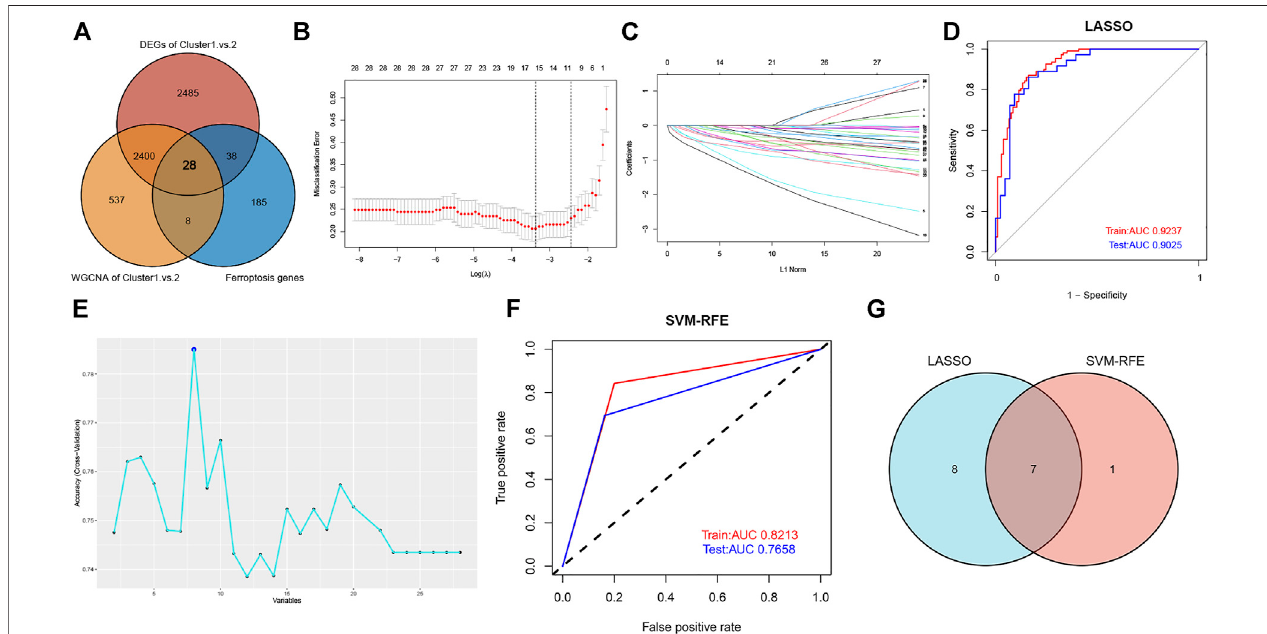
FIGURE 8 | Construction of ferroptosis signature using machine learning algorithms. (A) Venn plot showing the co-expressional ferroptosis genes by intersecting the DEGs with the ferroptosis genes obtained from the FerrDb database. (B) The optimal lambda value was selected in the LASSO regression model based on 10-fold cross-validation. (C) TheLASSOcoef fi cientpro fi lesofthe28co-expressionalferroptosisgenes. (D) Veri fi cationofthediagnosticvalueoftheLASSOmodelinthetraining and testing sets by using ROC analysis. (E) The line graph showing the cross-validated accuracy based on different numbers offerroptosis genes in the SVM-RFE model. (F) Veri fi cation ofthediagnostic valueoftheSVM-RFE model inthetrainingand testingsets byusingROCanalysis. (G) Screeningofsevenkeyferroptosis genes using LASSO and SVM-RFE machine learning